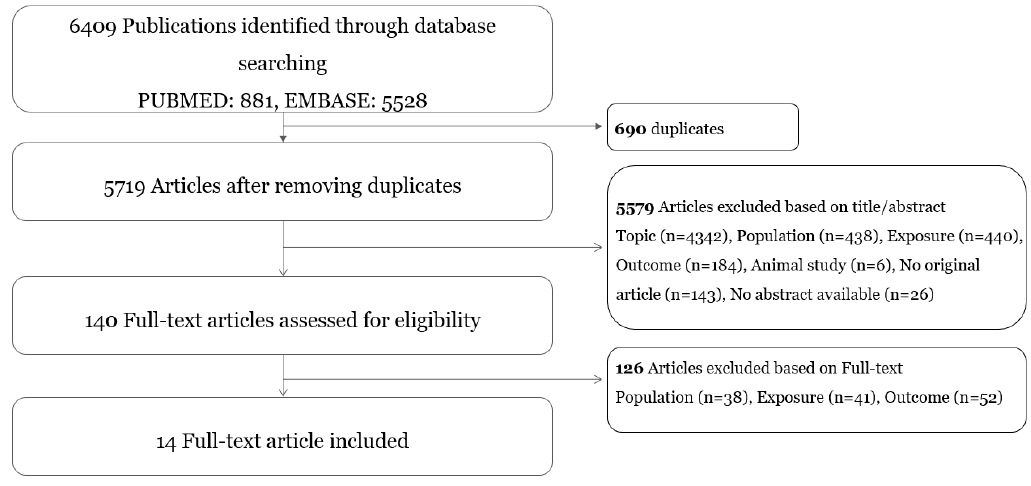
Figure 1. Flowchart of the study selection .